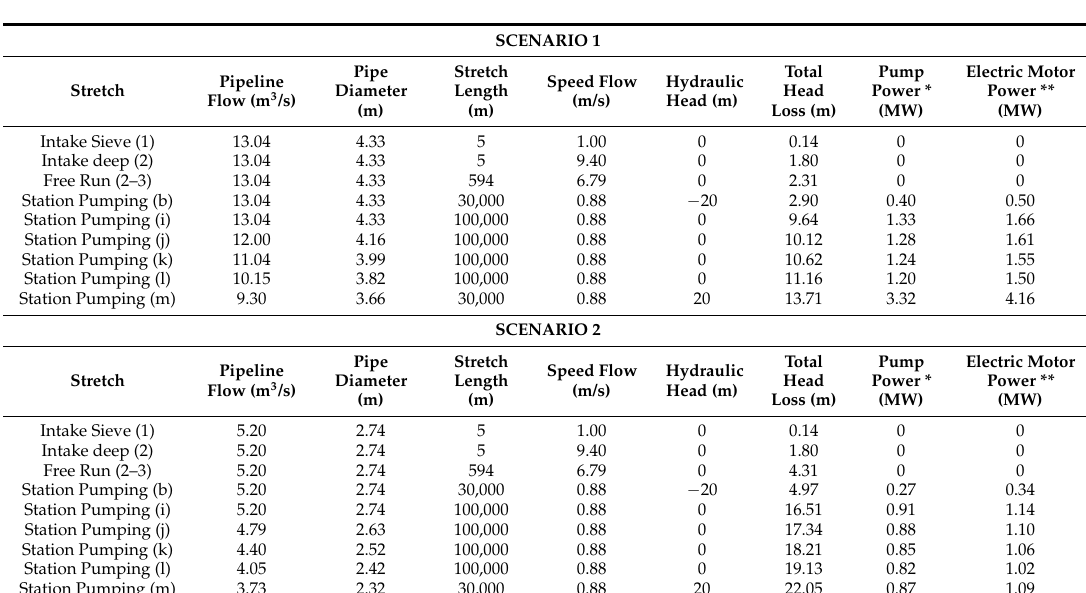
Figure 11. Stretches of the route of the underwater pipeline River Parnaíba/Fortaleza, Brazil. Table 4. Characterization of Pipelines of River Parnaíba/Fortaleza, Brazil. Scenario 1 (200 L/capita/day), Scenario 2 (81 L/capita/day).